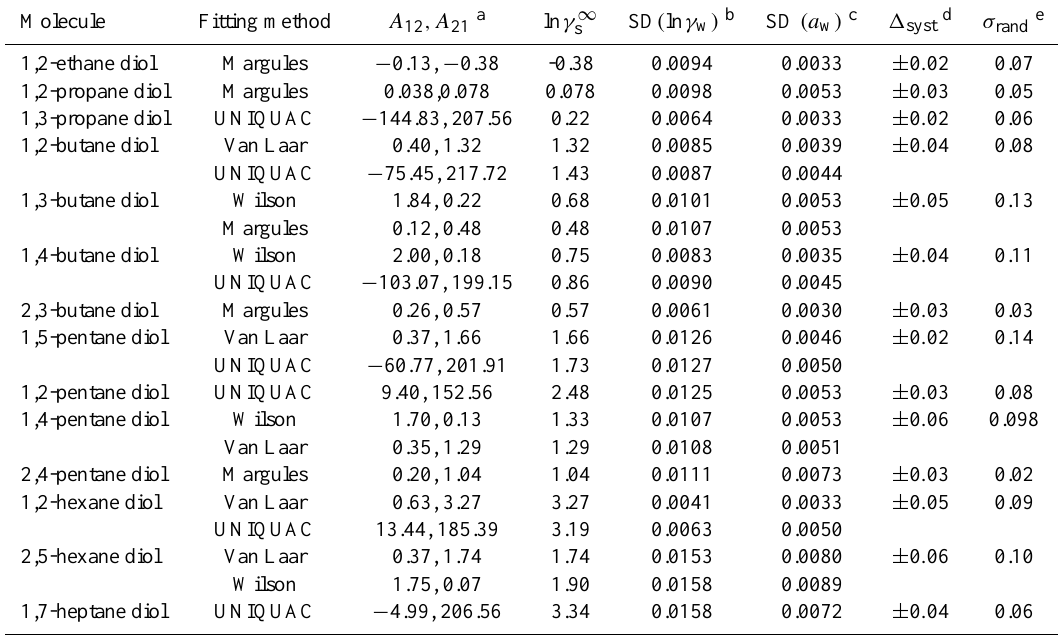
Table 6. Activity coefficient methods that best fit the data of Marcolli and Peter (2005). For seven compounds, an alternative fitting is